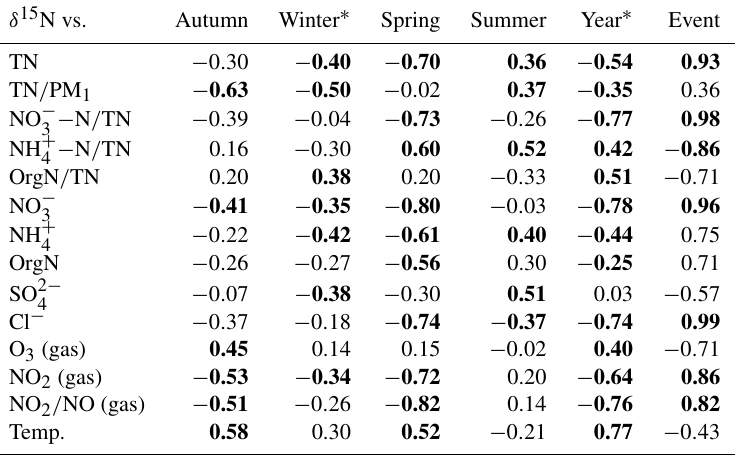
Table 2. Spearman correlation coefficients ( r ) of δ 15 N with various tracers. Only bold values are statistically significant ( p values <0.05). δ 15 N vs.